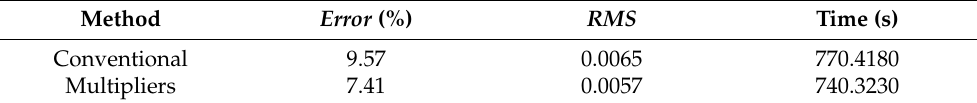
Table 1. Model error, RMS data fitting error, and inversion time for the heave model. Method